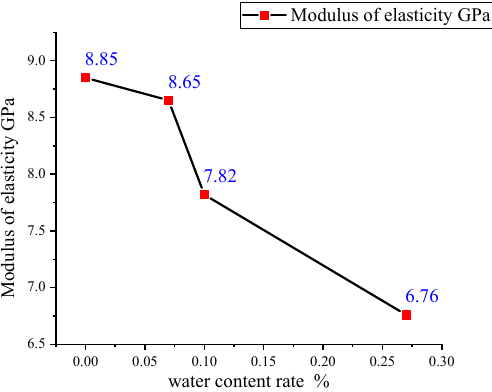
Figure 4. Modulus elasticity of limestone samples with different water content rates.